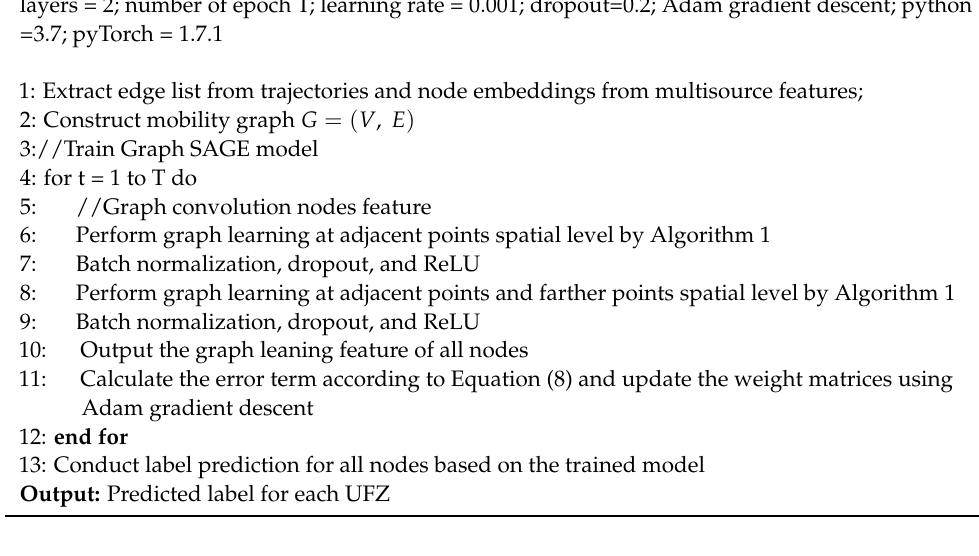
Algorithm 2: Proposed graph-based framework for UFZ